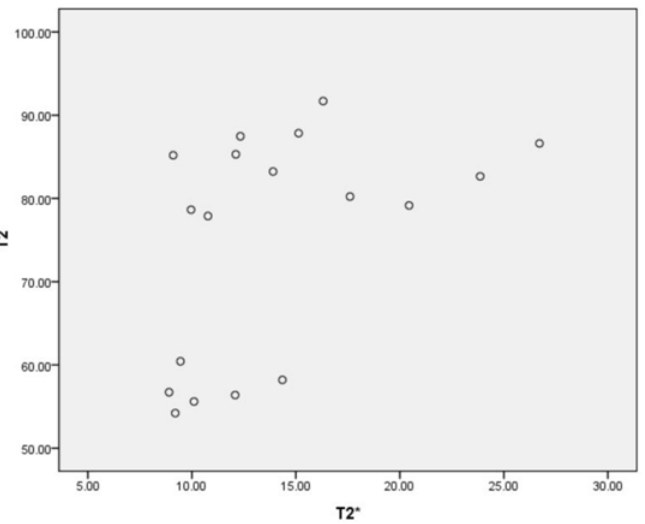
Fig 11. The scatter diagram of T2 values and T2 * values. A correlation was found between T2 and T2 * values ( P < 0.001). N = 18.